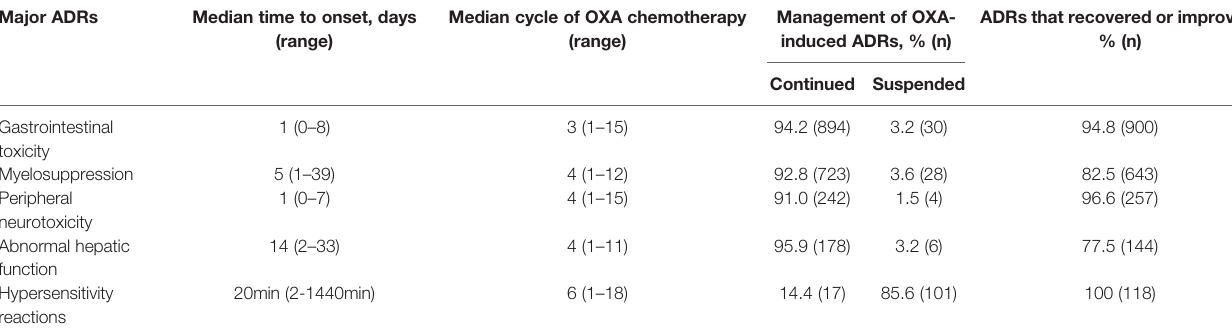
TABLE 4 | Time to onset, cycle, management and outcome of major